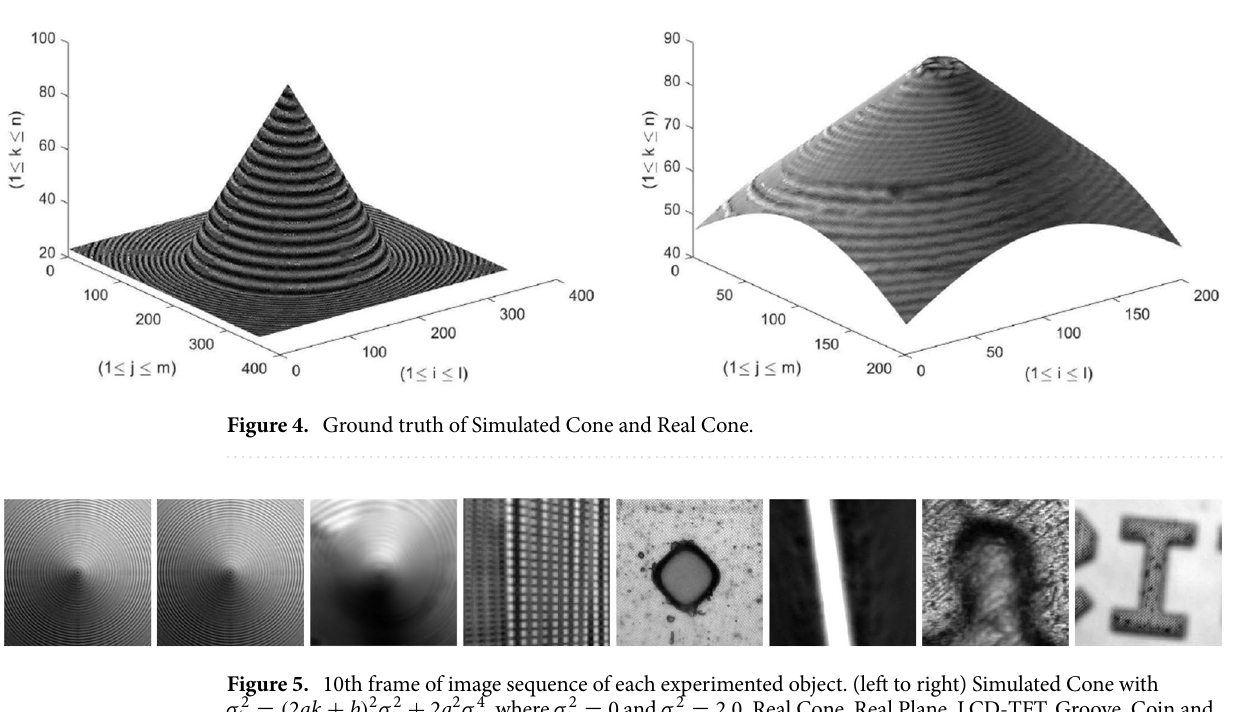
0 and σ 2 2.0 , Real Cone, Real Plane, LCD-TFT, Groove, Coin and σ 2 ζ = ζ =